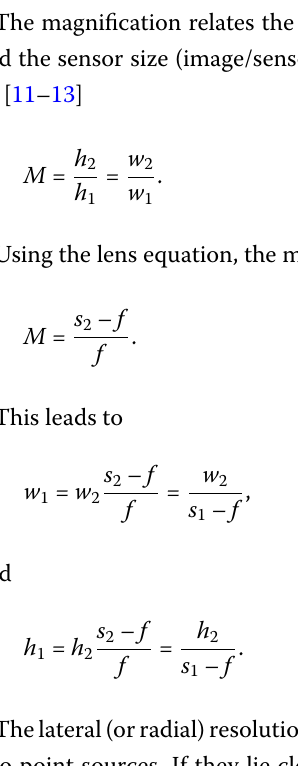
f , s 1 , and s 2 being the focal length, object distance, and image distance, respectively. Focusing is done by moving the lens, which is described by the lens rack out distance (cid:3) s lens ( s 2 = f + (cid:3) s lens ). The maximum lens rack out distance (cid:3) s lens 2 distance of the focal